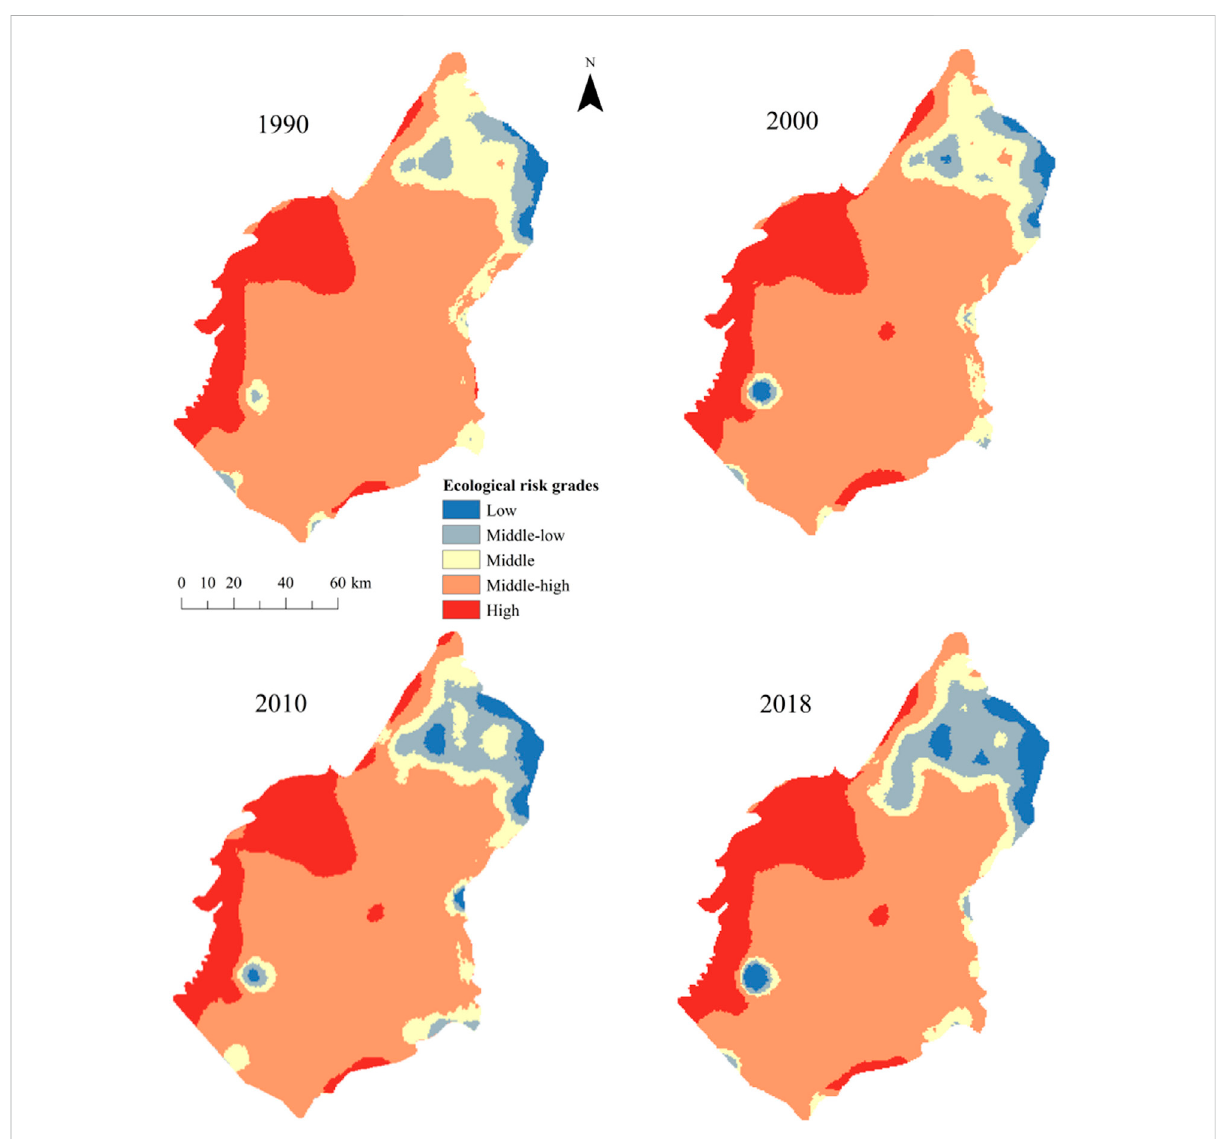
FIGURE 4 Spatial distribution of the ERI in the Ulan Buh Desert in 1990 –